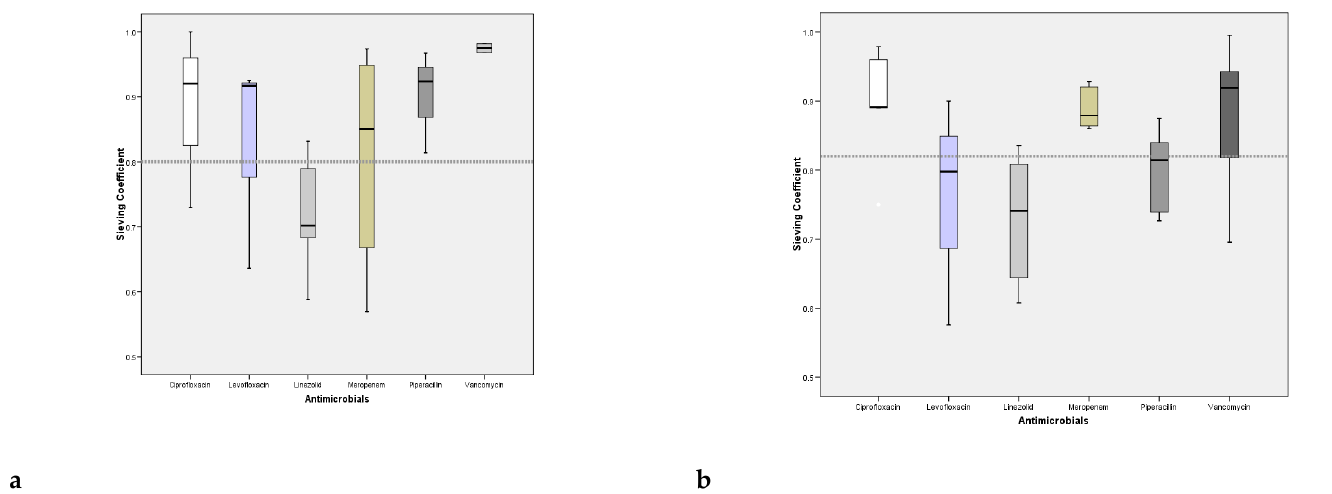
Figure 2. Sieving coefficients at the peak and valley of the antibiotics studied (continuous infusion for Vancomycin has been used). Figure 3a,b show the linear regression between the concentration of the drug in UF and plasma; values are presented for both trough level and peak concentration; the relation between the drug concentrations in the two fluids is very close, confirmed by the R2 presented in the figures. The higher is the plasma concentration of the antimicrobials the higher is the UF one.